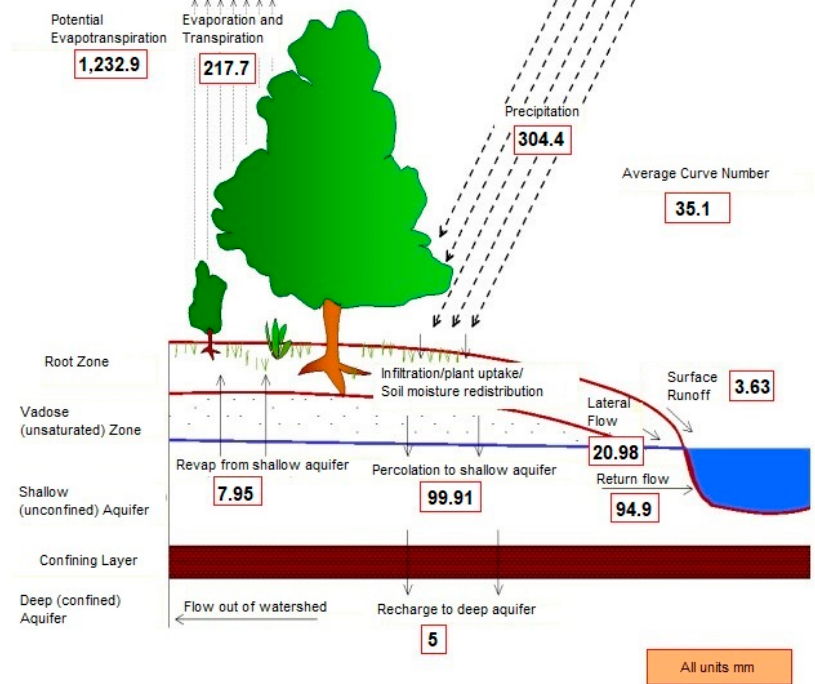
Figure 9. Guadalupe Basin Average Hydrological Balance.